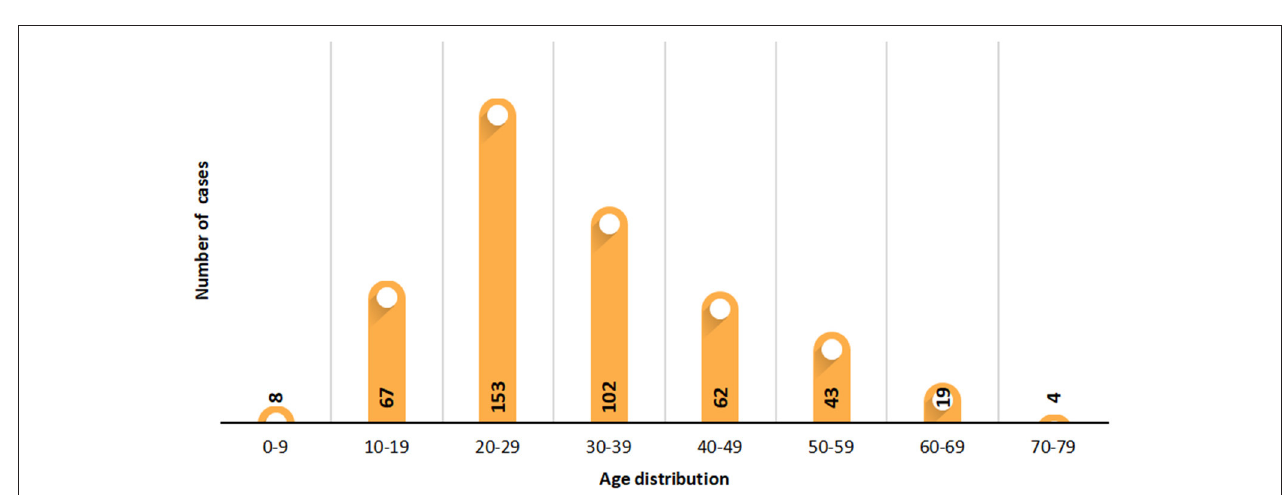
FIGURE 2 | Distribution of exported countries and distribution of imported provinces.